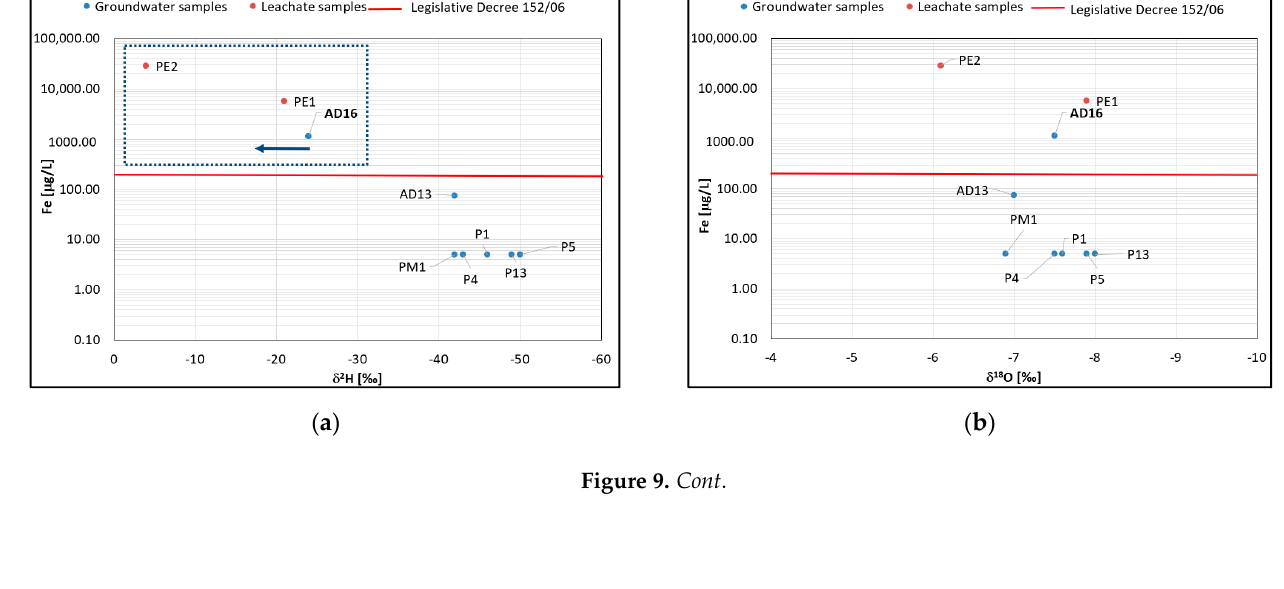
( f ) Figure 9. Scatter plot ( a ) Fe and δ 2 H, ( b ) Fe and δ 18 O, ( c ) Mn and δ 2 H, ( d ) Mn and δ 18 O, ( e ) Ni and δ 2 H and ( f ) Ni and δ 18 O . Further regarding to this case study, the presented comparison between δ 2 H enrichment and other metals, outlines that, when there is a δ 2 H enrichment and one metal high concentration values, these latter values are due to contamination process, and they can’t be referred to a natural background level. The same outline is not present for 18 O, as this element one is not involved in such a process.